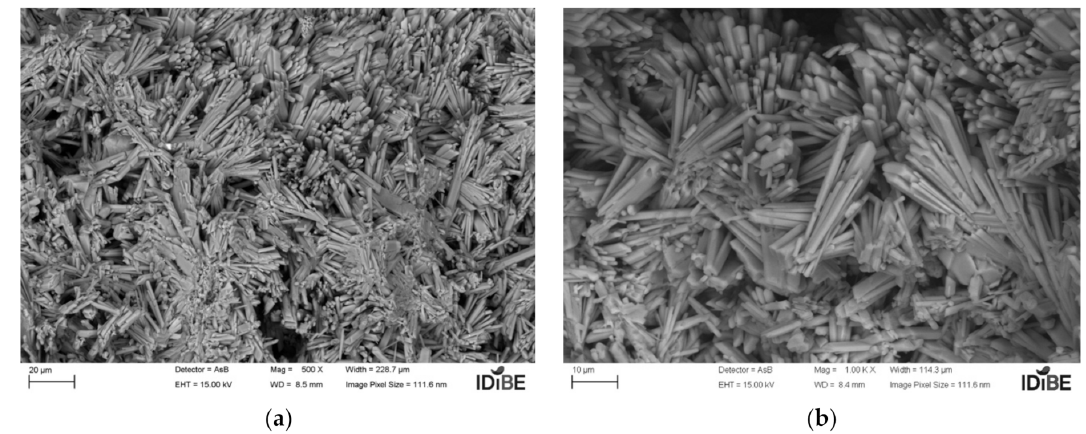
Figure 6. Micrograph of the 0.2% melamine compound (lot C1): ( a ) 20 µ m; ( b ) 10 µ m (source: the